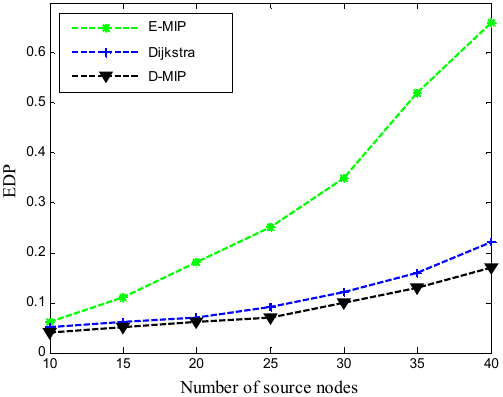
Figure 14. The effect of the number of source nodes on EDP. Figure 14. The e ff ect of the number of source nodes on